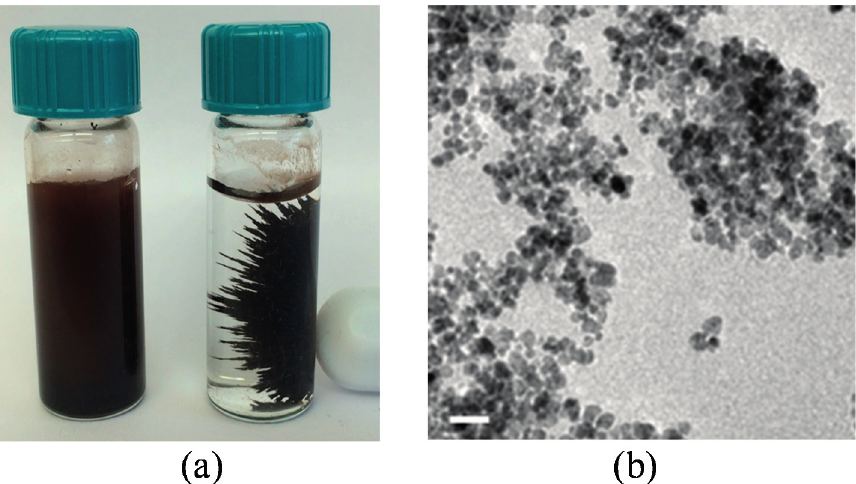
Figure 6. ( a ) Photograph of magnetite IONPs; left vial contains suspended IONPs while the Right vial contains IONPs subjected to a permanent magnet; and ( b ) TEM image of magnetite IONPs with 50 nm scale bar.